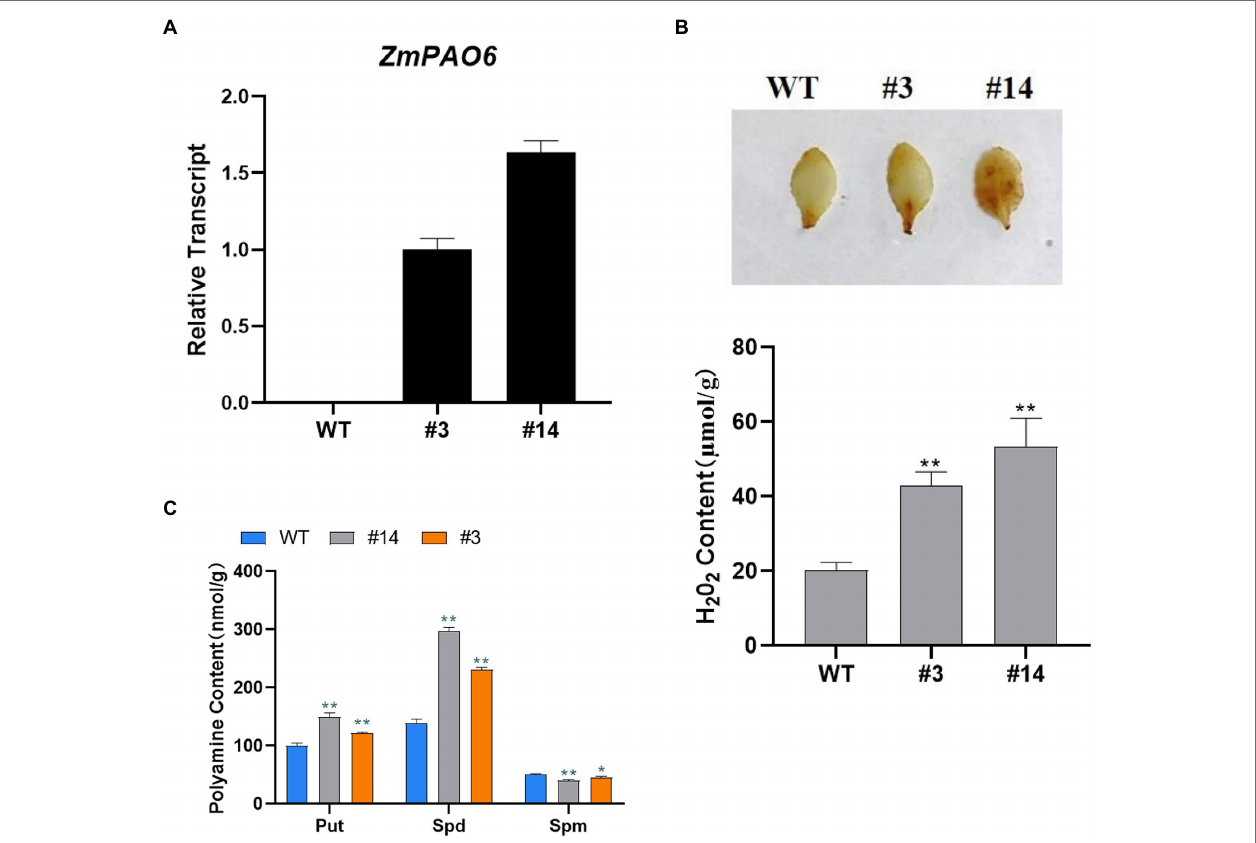
FIGURE 10 | Overexpression of ZmPAO6 gene leads to changes in characteristics of transgenic Arabidopsis . (A) Molecular characterization of transgenic lines by qRT-PCR analysis. (B) H 2 O 2 contents in WT and transgenic lines. (C) PAs contents in WT Arabidopsis and transgenic lines detected by HPLC. Error bars are caused by three biological replicates. Asterisks above the error bars represent statistical significance using one-way ANOVA and a Fisher’s LSD. * Significantly different at p < 0.05; ** significantly different at p <